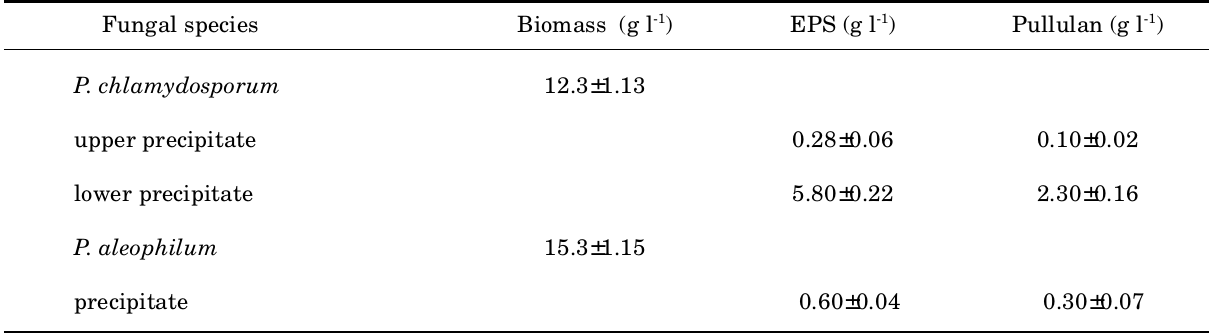
Table 2. Exopolysaccharide (EPS) and pullulan production by P. chlamydosporum and P. aleophilum in 28-day-old stationary cultures a .